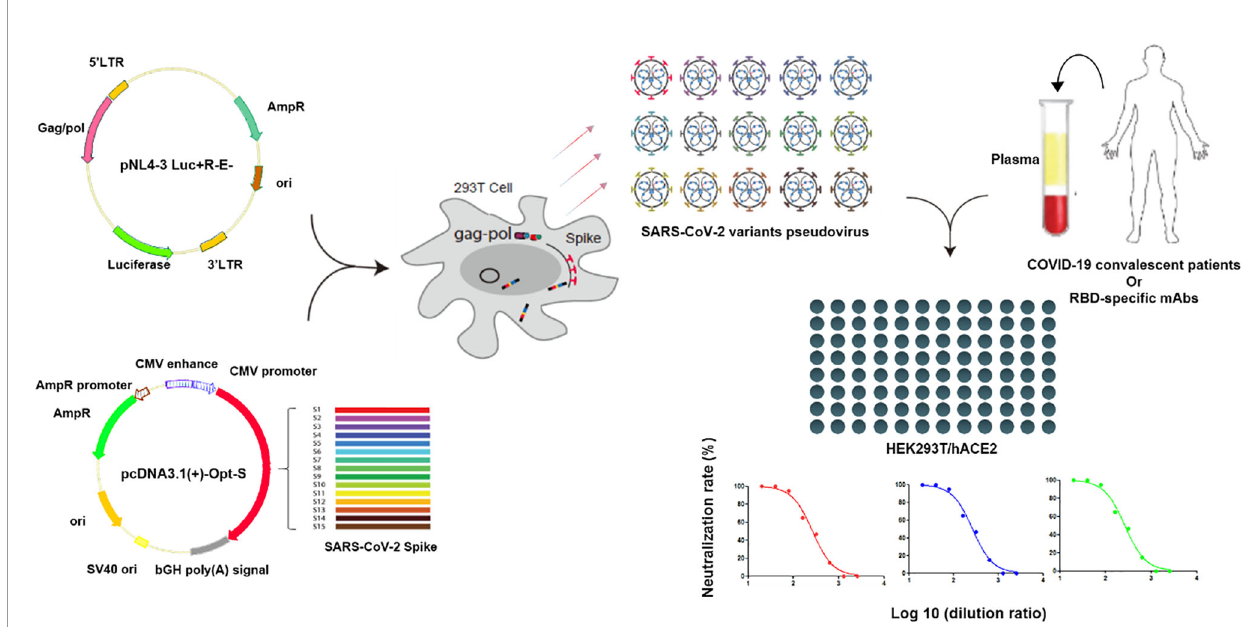
FIGURE 2 | Illustration of pseudovirus production and neutralization assay. Pseudoviruses were produced by the co-transfection of HEK293T cells with pNL4-3 Luc+R-E- and pcDNA3.1(+)-Opt-S plasmids expressing spike proteins. Neutralization assay was performed by incubating the pseudovirus with diluted convalescent plasmas or mAbs, and the neutralization rates were detected in the HEK293T/hACE2